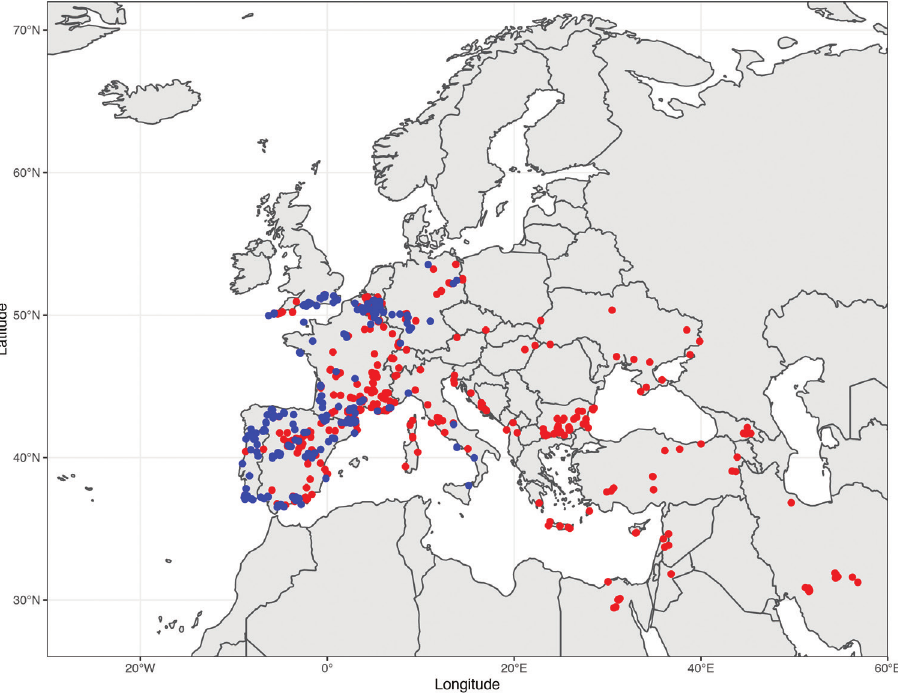
Figure 7. Distribution map of Andrena ovatula (blue dots) and A. afzeliella (red